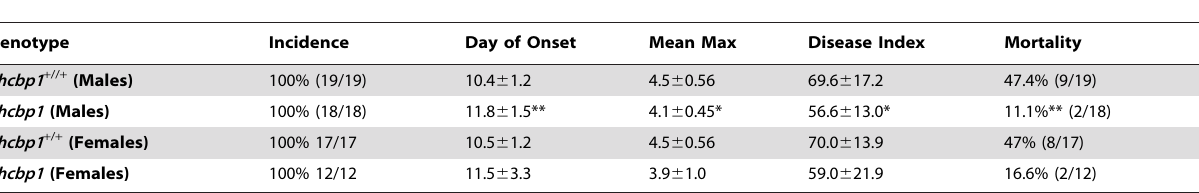
Table 1. Parameters of EAE disease in Shcbp1 + / + and Shcbp1 2 / 2 mice.